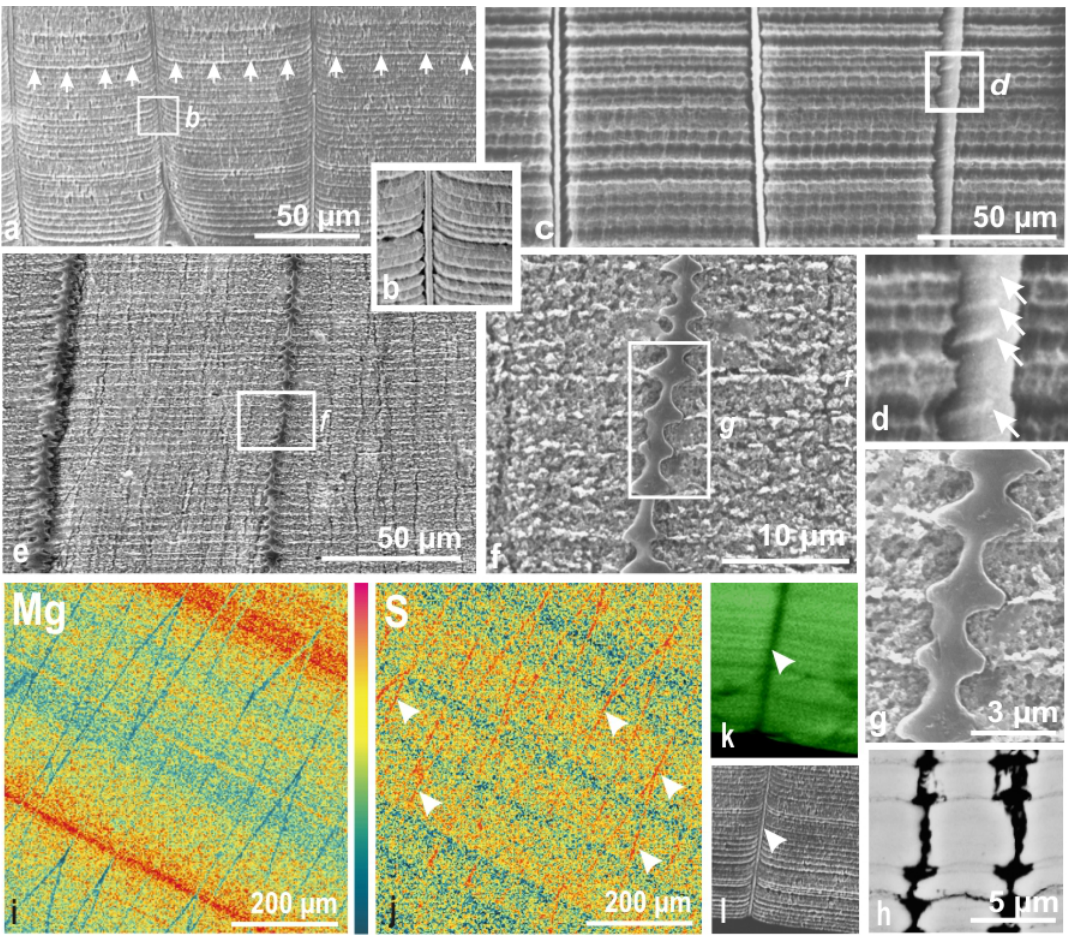
Figure 2. Simultaneous growth of organic envelopes and mineralized components of the prisms. ( a , d ) enzymatic etching (a,b) and acido-fixative etching ( c ) provide complementary evidence of a perfect synchronism in deposition of growth layers forming the prismatic outer part of the Pinna shells. Note that a stepping growth mode of envelopes is directly visible on their internal side. Figure 1j has shown that each growth layer can be separated from the others through soft hydrolysis process. ( e – h ) Calcitic prisms produced by Pinctada mantle also exhibit perfect synchronism in deposition ( e , f ). In addition, the stepping growth mode of envelopes is sometimes quite obviously illustrated, as here in the prismatic layer of a pearl bed ( f , g ). Using back scattered electrons, the high contrast between mineralized and purely organic parts emphasizes the morphological details resulting from the stepping growth mode ( h ); ( i , j ) Microprobe distribution maps of magnesium and sulfur on a polished section in a Pinna shell. Section almost perpendicular to shell surface: prisms are cut in their length but slightly obliquely; ( k – l ) Distribution of sulfated polysaccharides by synchrotron based X-ray absorption of sulfur (k) shows that prism envelopes (l: arrow) do not contain polysaccharides, although sulfur is abundant as shown by microprobe mapping (2 j ): envelopes are mostly protein made (see also Figure 3h) . In addition the layered distribution provides additional evidence of the organic-mineral interplay within each growth